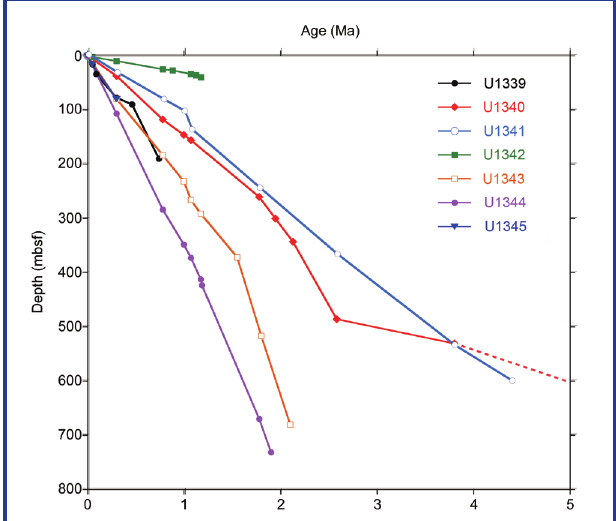
Figure 3. Age vs depth plots showing varying sedimentation rates observed at Sites U1339–U1345. The dashed line at the bottom of Site U1340 indicates the extrapolated bottom age based on the ages found further